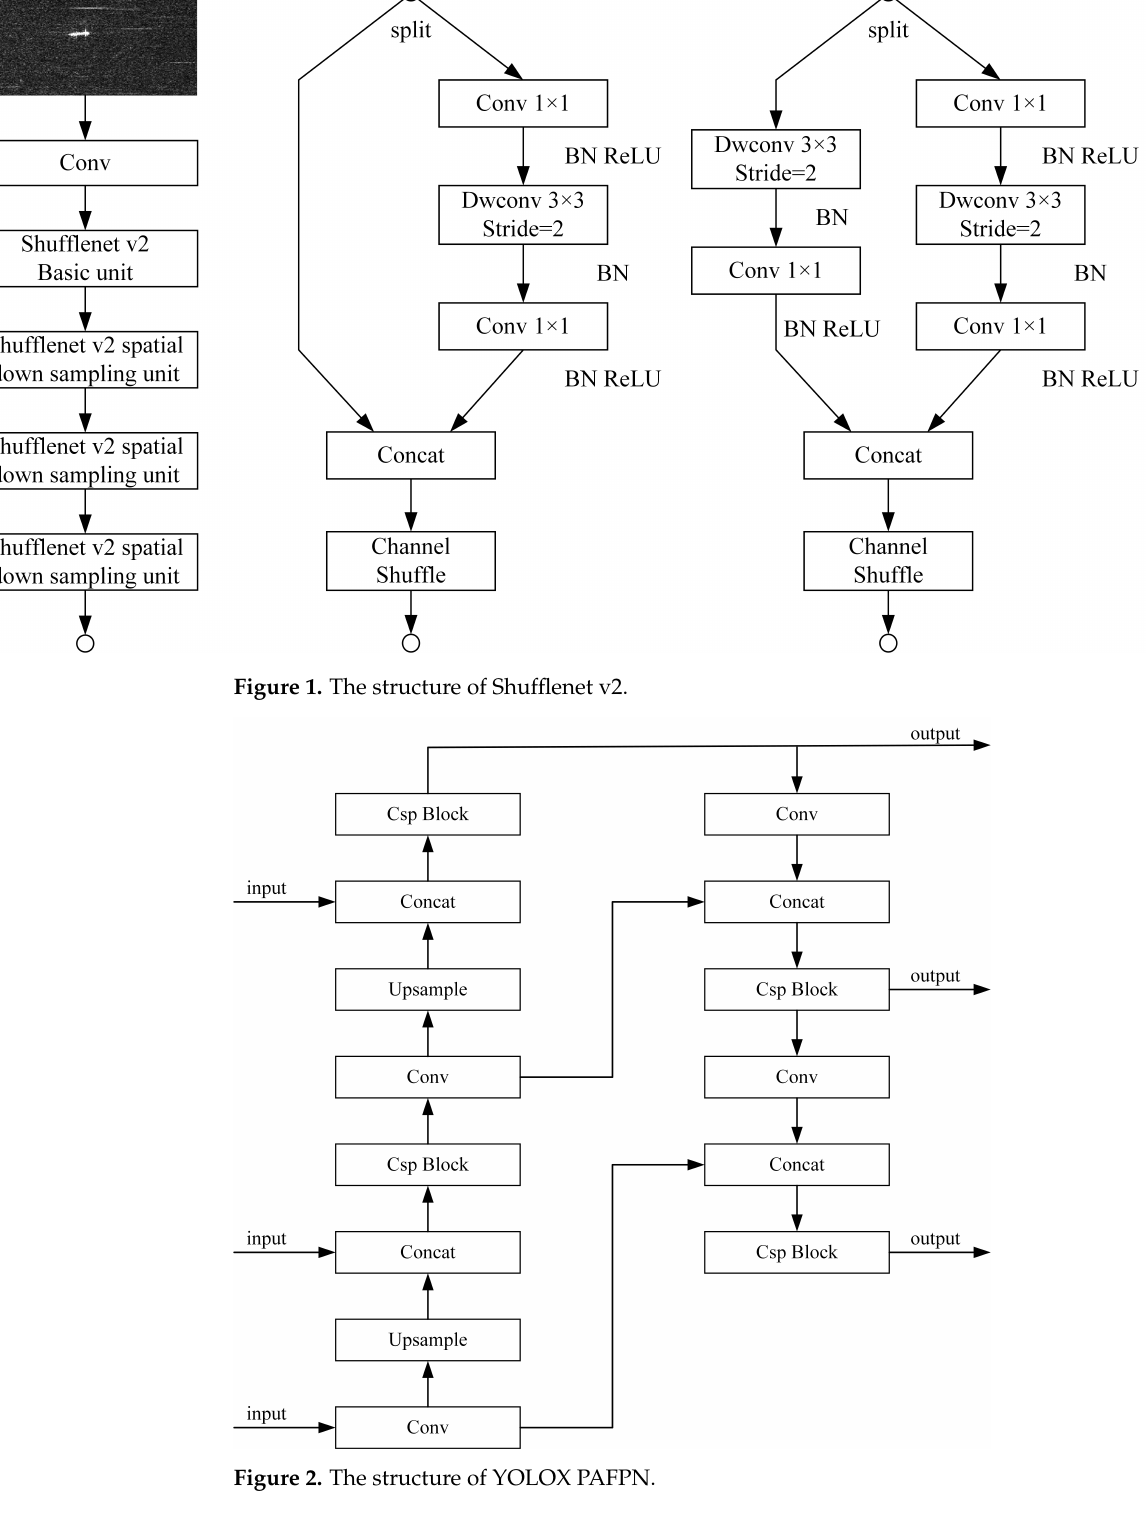
Figure 2. The structure of YOLOX PAFPN. LssDet’s prediction network is based on the YOLOX Decopuled Head [28]. Most